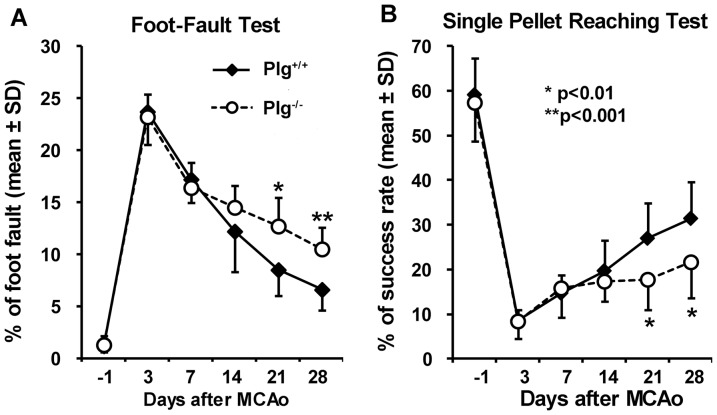
Behavioral outcome after MCAo.A: The foot-fault test measures the accuracy of forepaw placement on a non-equidistant grid as the percentage of foot-faults of the left forepaw to total steps. B: The single pellet reaching test measures the ability of skilled forepaw use. Animals were trained to use their left forepaw to extract food pellets through a vertical slot of the front wall. The number of the left forepaw extensions through the slot and the number of pellets extracted were counted. Performance was defined by the success rate as the percentage of pellet number extracted per left forepaw attempts. After stroke, significant behavioral deficits were evident in both tests. The Plg+/+ mice showed a progressive improvement with time, while the Plg-/- mice exhibited a significant delayed recovery compared with the Plg+/+ mice (n = 10/group, *p<0.01, **p<0.001).